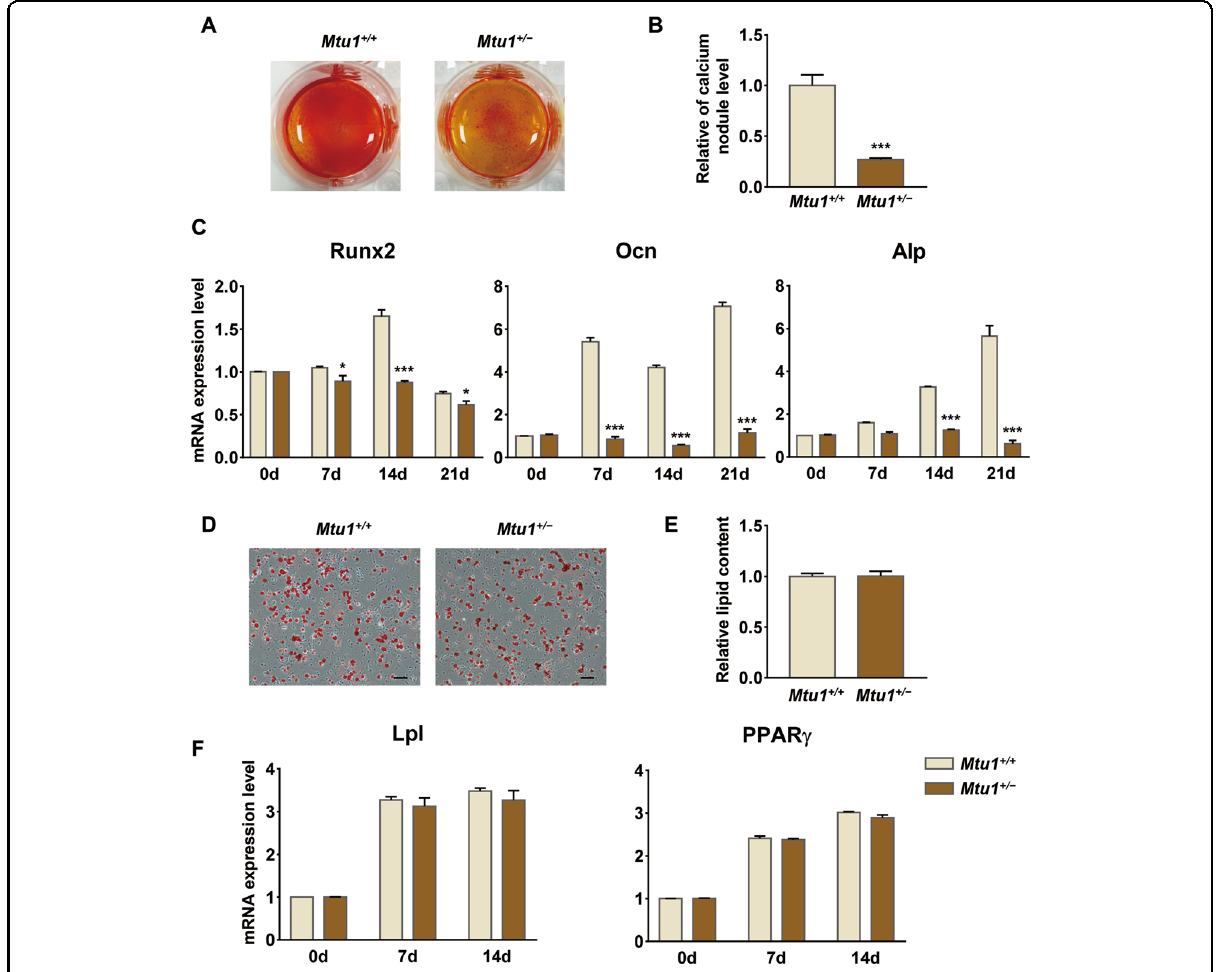
mineralized calcium deposits in cells after 14 days of osteogenic differentiation. The fi gures show one representative result of at least three experiments. C RT-qPCR at 0, 7, 14, and 21 days for mRNA levels of osteoblast differentiation markers, including Runx2 , Ocn , and Alp . D , E Oil Red O staining and quanti fi cation of accumulated lipid droplets in cells after 14 days of adipogenic differentiation. The fi gures show one representative result of at least three experiments. Scale bars: 100 μ m. F RT-qPCR at 0, 7, and 14 days for mRNA levels of adipocyte differentiation markers including Lpl and PPAR γ . Scale bars: 100 μ m; * P < 0.05; *** P <